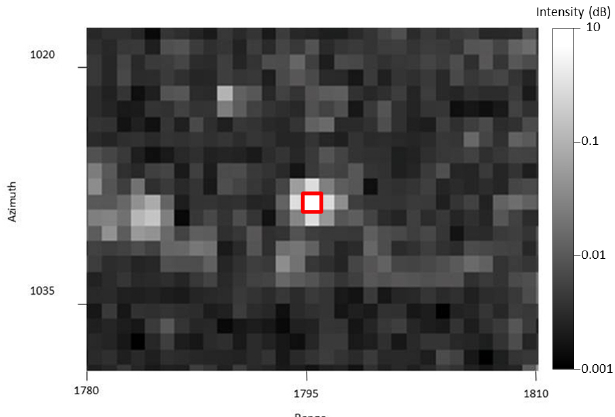
Figure 6. Detection of 955 cm-side CR (CR1) in Sentinel-1 descending image—Intensity image on